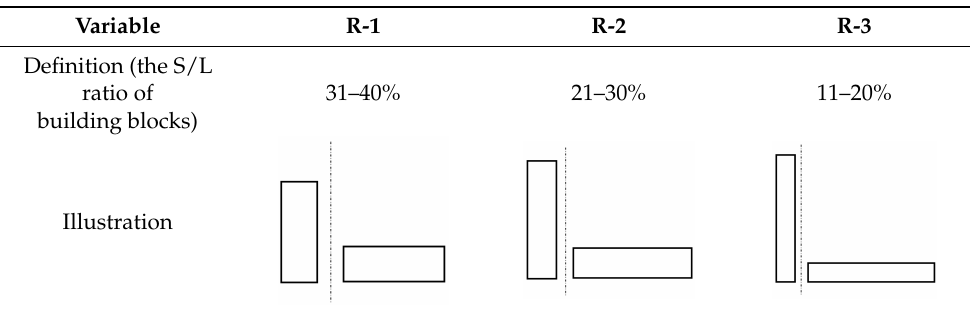
Table 5. Criteria of the S/L ratio of building blocks.